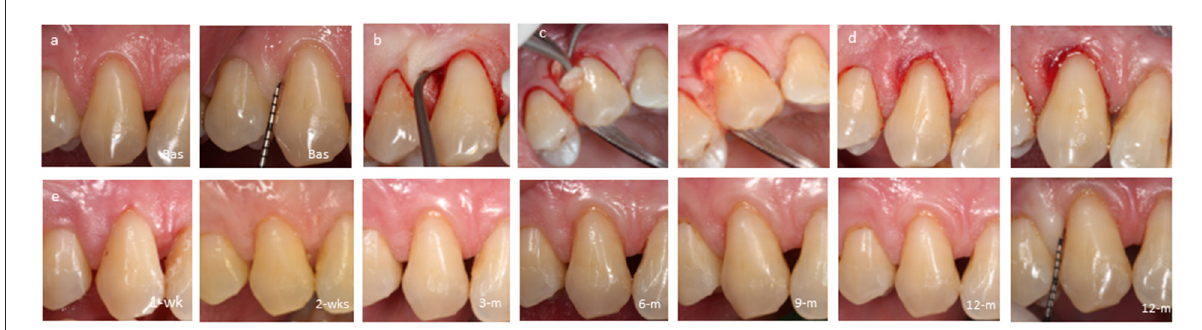
FIGURE4 Case-3, #13 distal: (a) baseline probing before anesthesia; (b) closed retraction of flaps; (c) subgingival application of the biocomplex; (d) immediate post-operative view; crosslinked autologous fibrin platelet lysate by CaCl 2 seals the sulcus; (e) follow-ups at 1-, 2- weeks, 3-, 6-, 9- and 12-months.